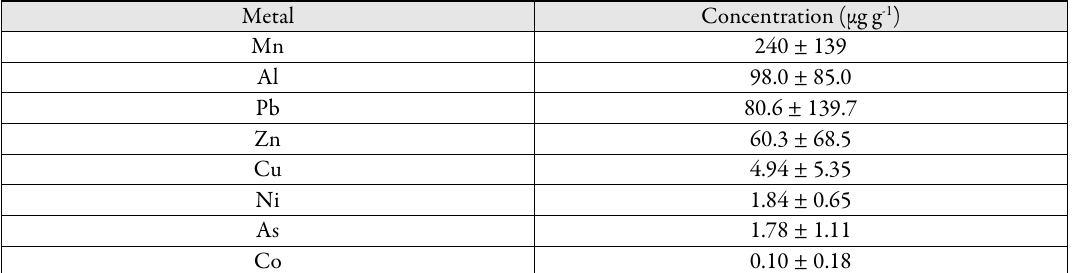
Table 1. Metal concentrations (mean ± standard deviation) in Nepenthes macfarlanei at the Genting Highlands, Malaysia; metals are ordered by their concentration in the leaf tissue